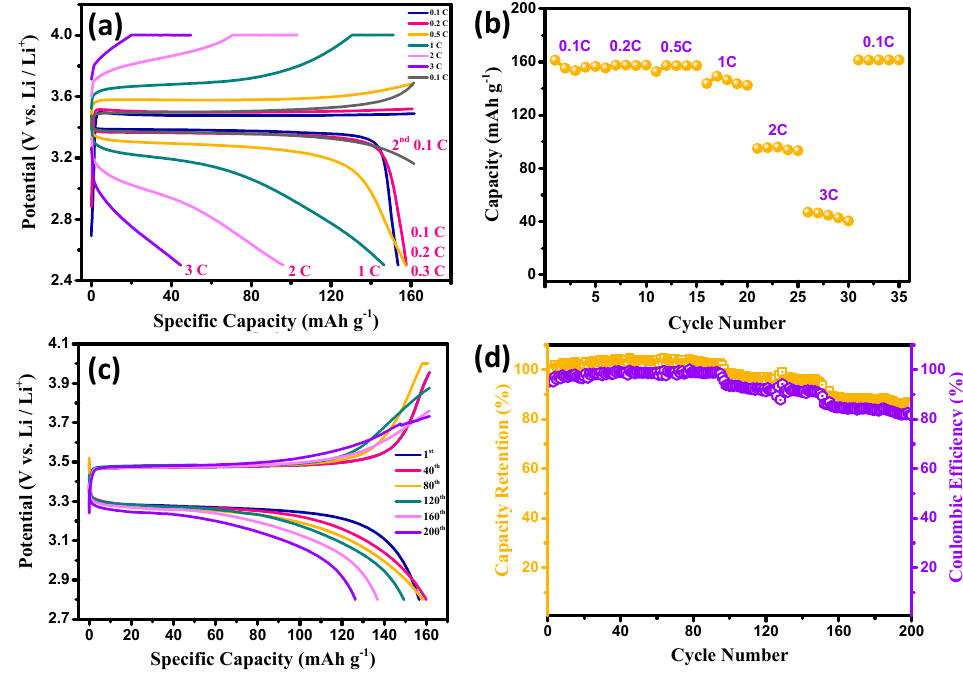
Figure 7. ( a ) Typical charge–discharge curves at various rates, ( b ) variations in specific capacity with C rate, ( c ) charge–discharge curves at 0.5 C, and ( d ) cyclic performance of the test cells equipped with CSEs (PVDF-HFP/LATP = 2.0, thickness = 40 μ m, C content: 7 wt.%, and heat-treated temperature: 140 °C).